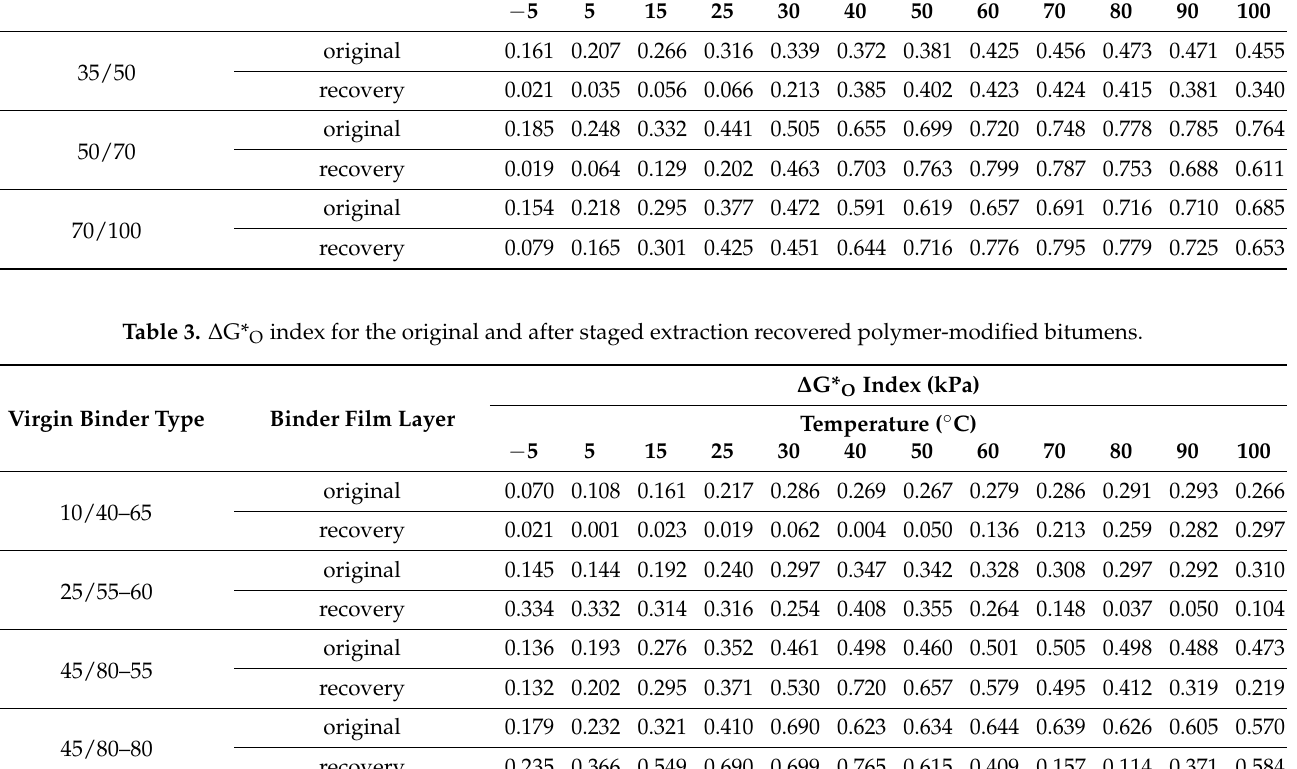
Virgin Binder Type